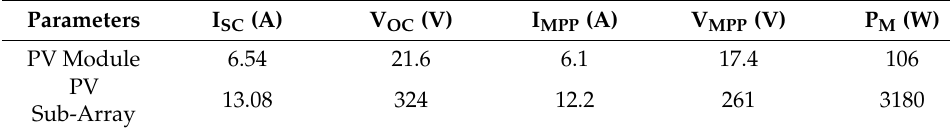
Figure 2. Illustrative diagram of the used grid-connected PV system. Table 1. Electrical Characteristic of PV Module and PV sub-array Isofoton I106-12.